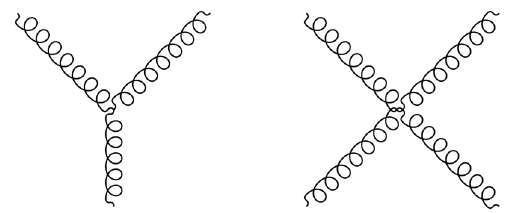
Fig. 1 3 and 4 gluon